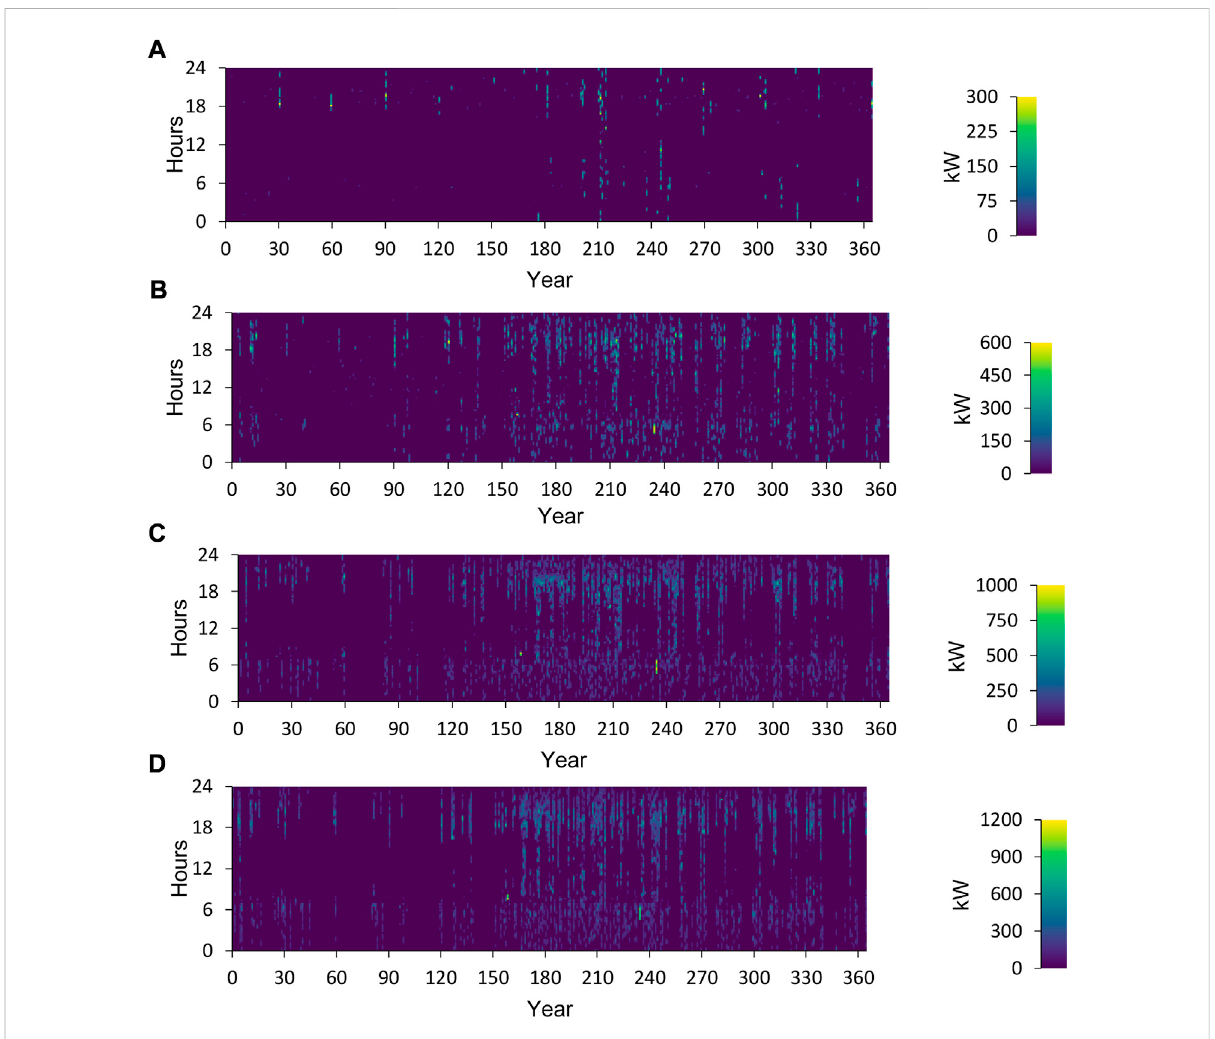
FIGURE 6 Power imports from the grid as per the scaled average daily sessions. (A) 10, (B) 20, (C) 30, and (D)